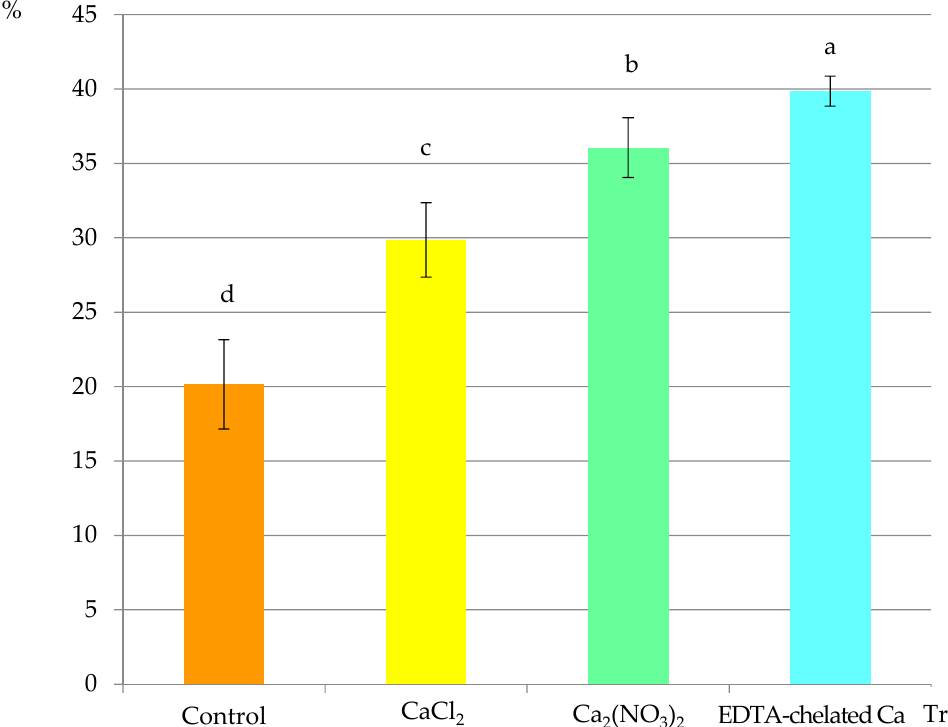
Figure 9. Ca 2 + content in fragments of epidermis cells from the apical part of ‘Szampion’ fruits in the control treatment and Ca foliar feeding variants. Means ( ± SD) marked with di ff erent letter above the bars are significantly di ff erent at p ≤ 0.05.